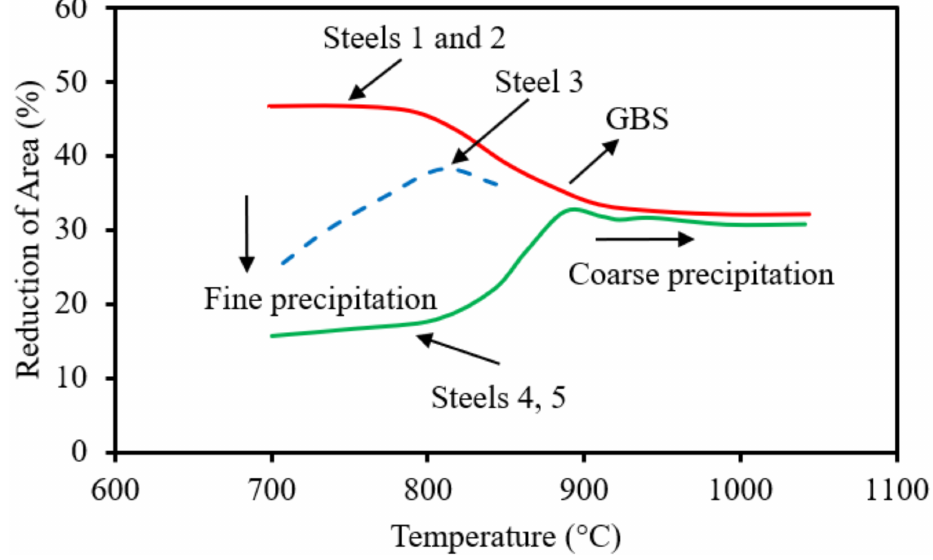
Figure 26. Hot ductility curves for V containing high Al TWIP steels 1–5 having respectively, 0.05, 0.11, 0.29, 0.5 and 0.75% V